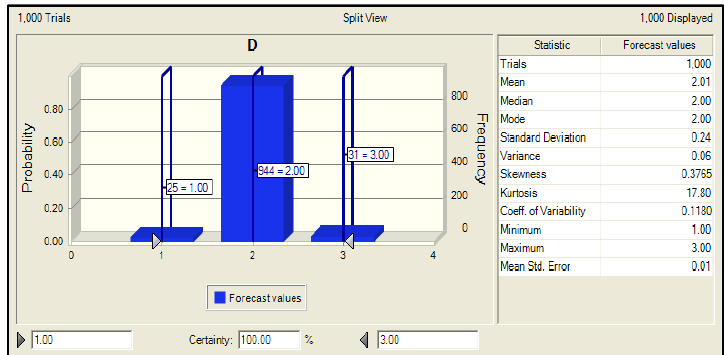
Figure 13. Case 1: Monte Carlo simulation of O in CB software.